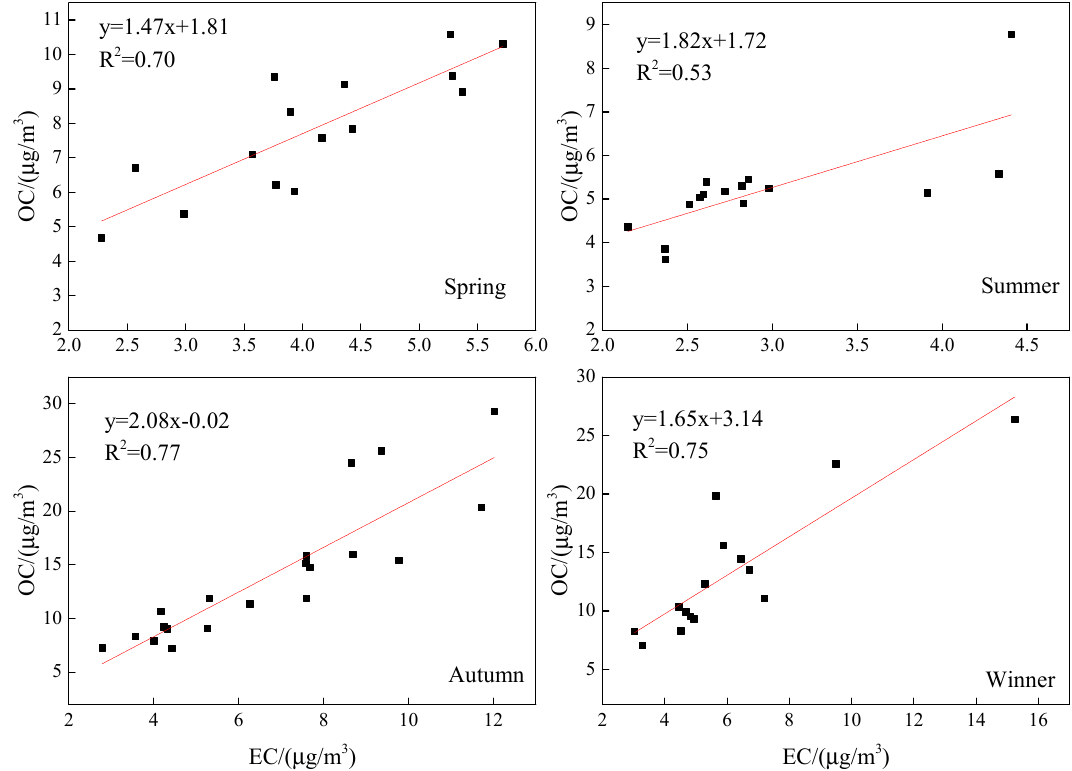
Figure 4. Correlation between OC and EC in PM 2.5 in four seasons from May 2017 to February 2018.